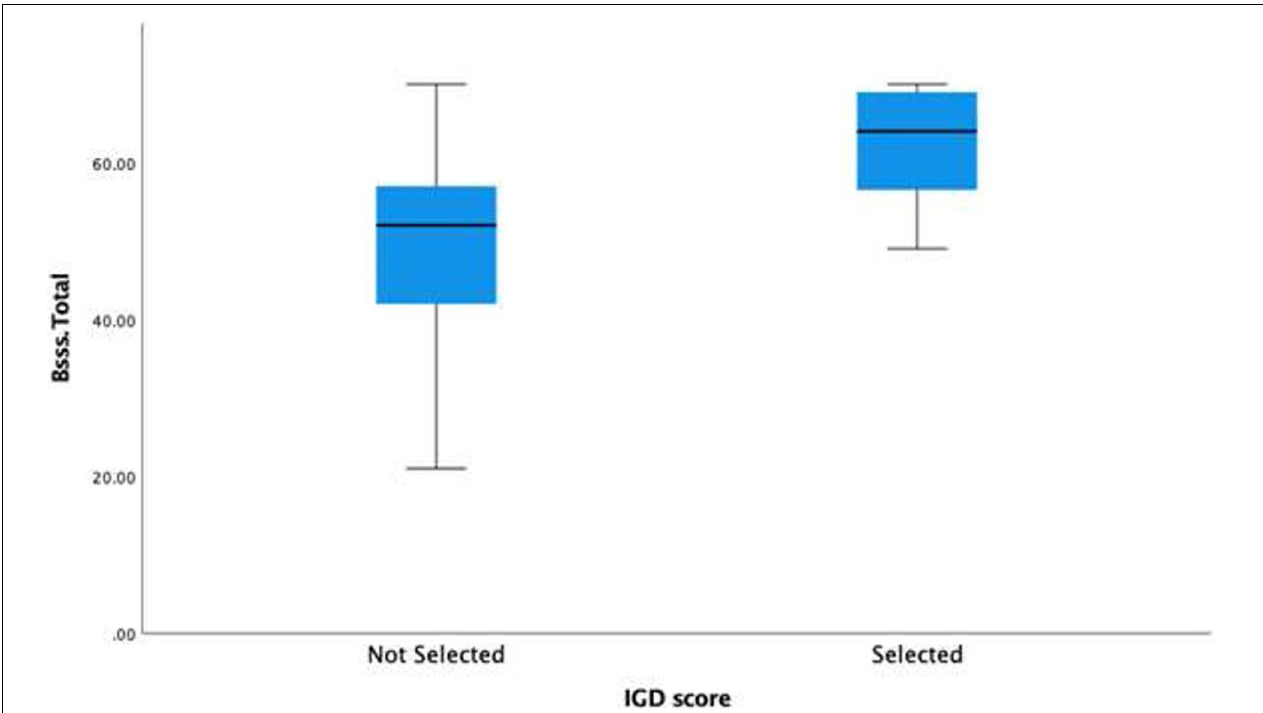
FIGURE 3 | Boxplot of the means and SDs of sensation seeking disorder based on clinical (selected) and non-clinical (not selected) internet gaming disorder (IGD) scores.